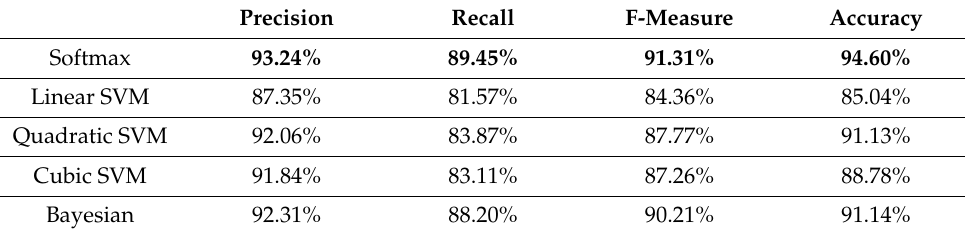
Table 8. Classification performance on contrast-enhanced images after dataset augmentation using original MobileNet-V2.